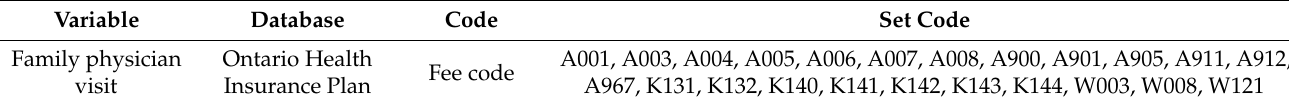
Table A3. Diagnostic codes for health care utilization